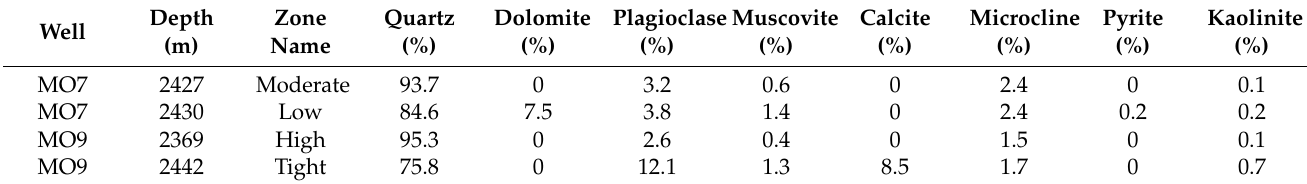
Figure 9. Correlation panel of flow zones showing lateral extension of the moderate and low flow zones in all the wells. The top high flow zone of well MO8 extends to well MO9 and truncated in well MO7 which may be due to erosion. Table 3. Quantitative XRD results showing the mineral content of different